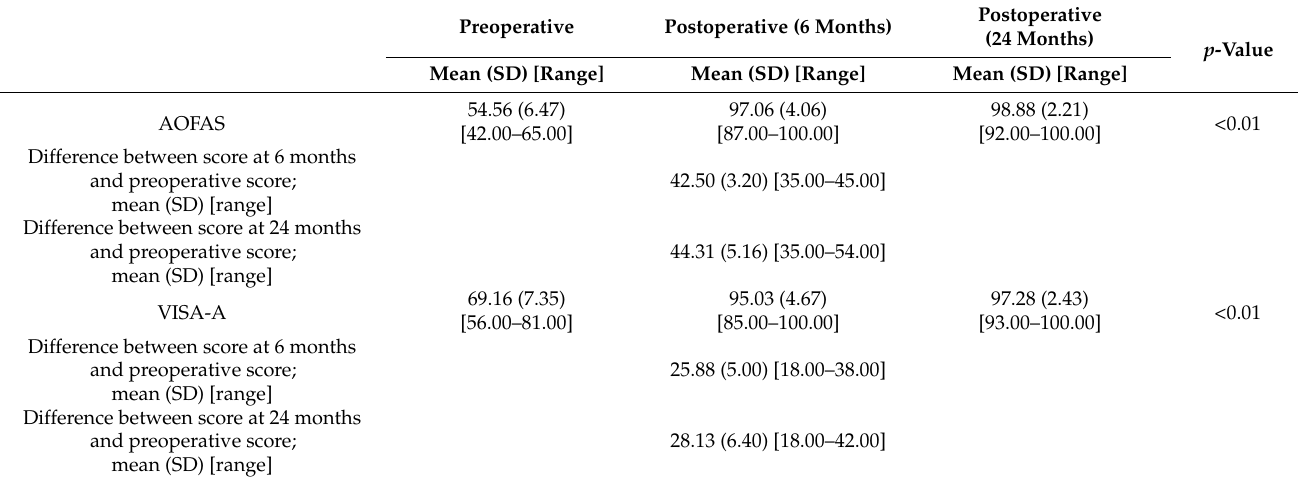
Table 3. AOFAS and VISA-A scores before the procedure and at 6 and 24 months.